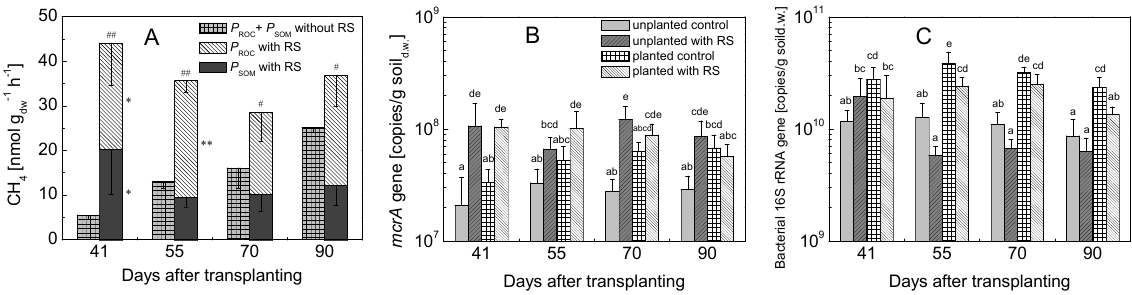
Fig. 2. Production rates of CH 4 and abundance of methanogens and Bacteria in planted microcosms without and with RS application. (A) Individual CH 4 production derived from ROC ( p ROC ) and SOM ( p SOM ) with RS application compared to total CH 4 production ( p ROC + p SOM ) without RS addition. The differences between p ROC + p SOM without RS and p ROC or p SOM with RS were tested by one-tailed independent t test, indicated beside the bars by ∗∗ when P <0.01 or ∗ when P <0.05. The differences between p ROC + p SOM without and with RS were tested as described above, indicated on the top of the bars by ## when P <0.01 or # when P <0.05; (B) mcrA gene (characteristic for methanogenic Archaea) and (C) bacterial 16S rRNA gene copy numbers without and with RS application; means ± SD ( n = 4). The differences between the treatments over time were examined using Duncan’s post hoc test of a one-way analysis of variance (ANOVA). Different letters on the top of bars indicate significant difference ( P <0.05) between the data.